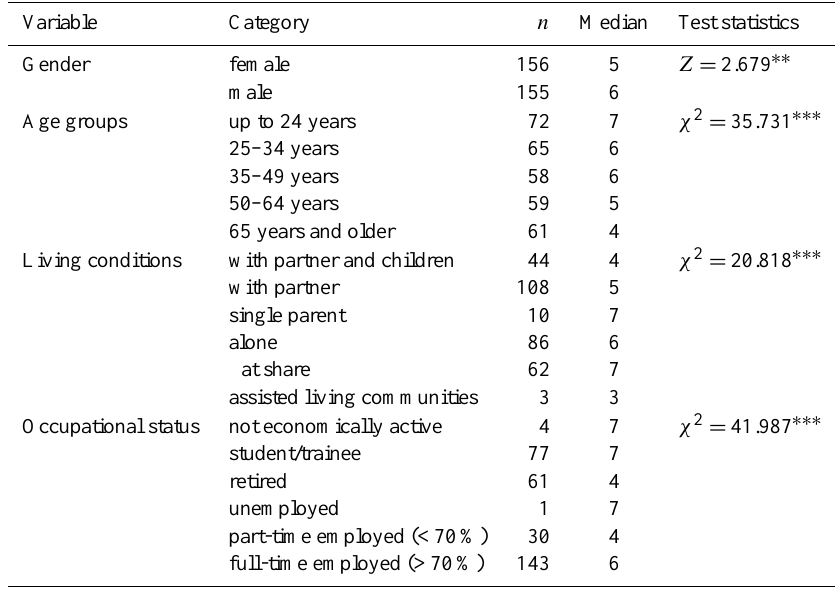
Table 3. Differences in subjective heat stress at home by sociodemographic